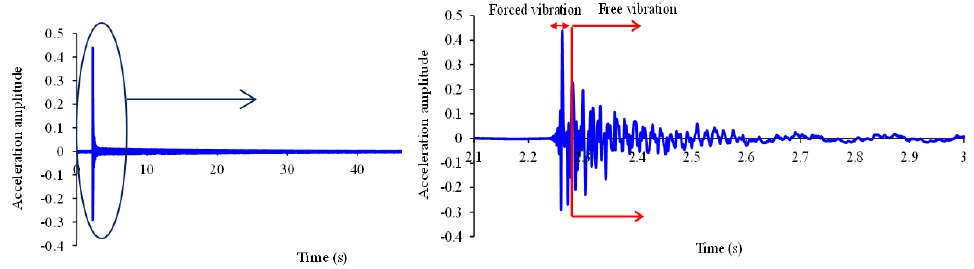
Figure 16. Acceleration response at location 3L/16.